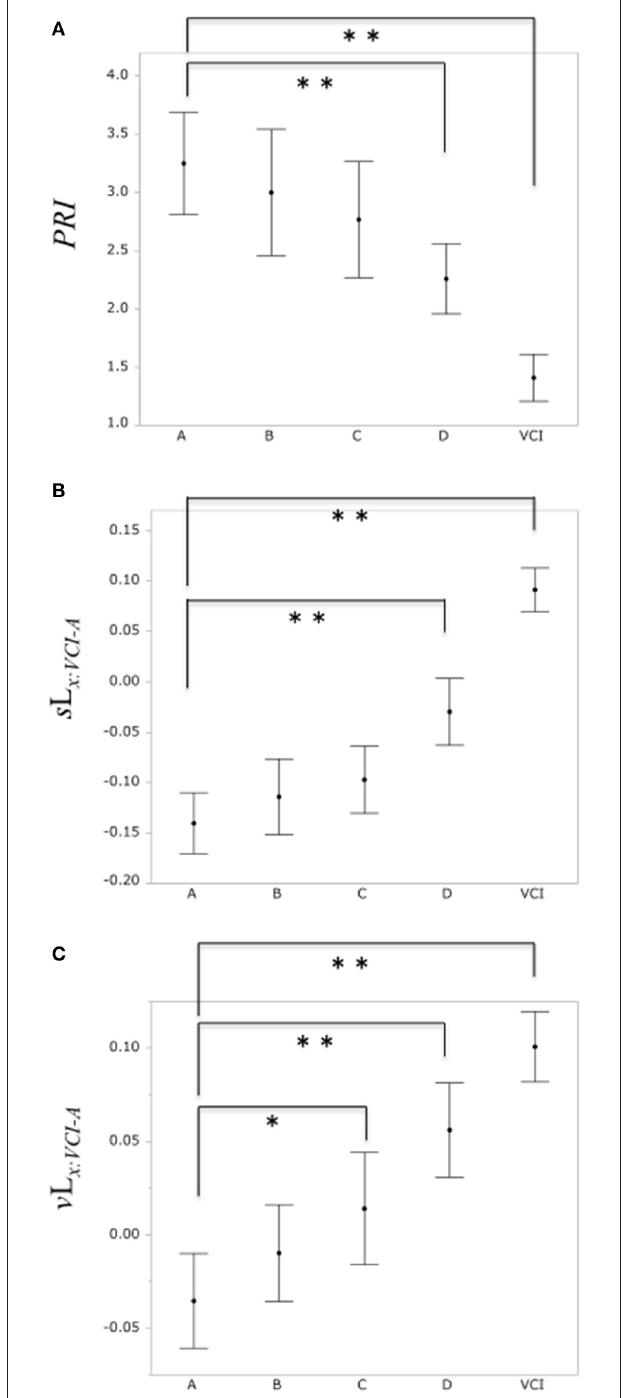
FIGURE 6 | (A) Comparison of PRI among the control group A and subclinical atherosclerosis groups (B, C, D), VCI group, respectively. (B) Comparison of the binary likelihood s L x : VCI − A among the control group (A) and subclinical atherosclerosis groups (B, C, D), VCI group, respectively. (C) Comparison of the binary likelihood v L x : VCI − A among the normal group (A) and subclinical atherosclerosis groups (B, C, D), VCI group, respectively. Each filled circle indicates the mean of the PRI, s L x : VCI − A , v L x : VCI − A , respectively, and each vertical line indicates 95% confidence intervals. * P < 0.05, ** P < 0.01.